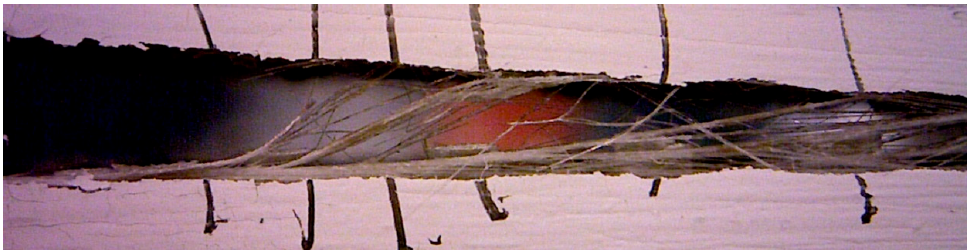
Figure 6. Crack propagation into the composite layer in a 3g-2s specimen.